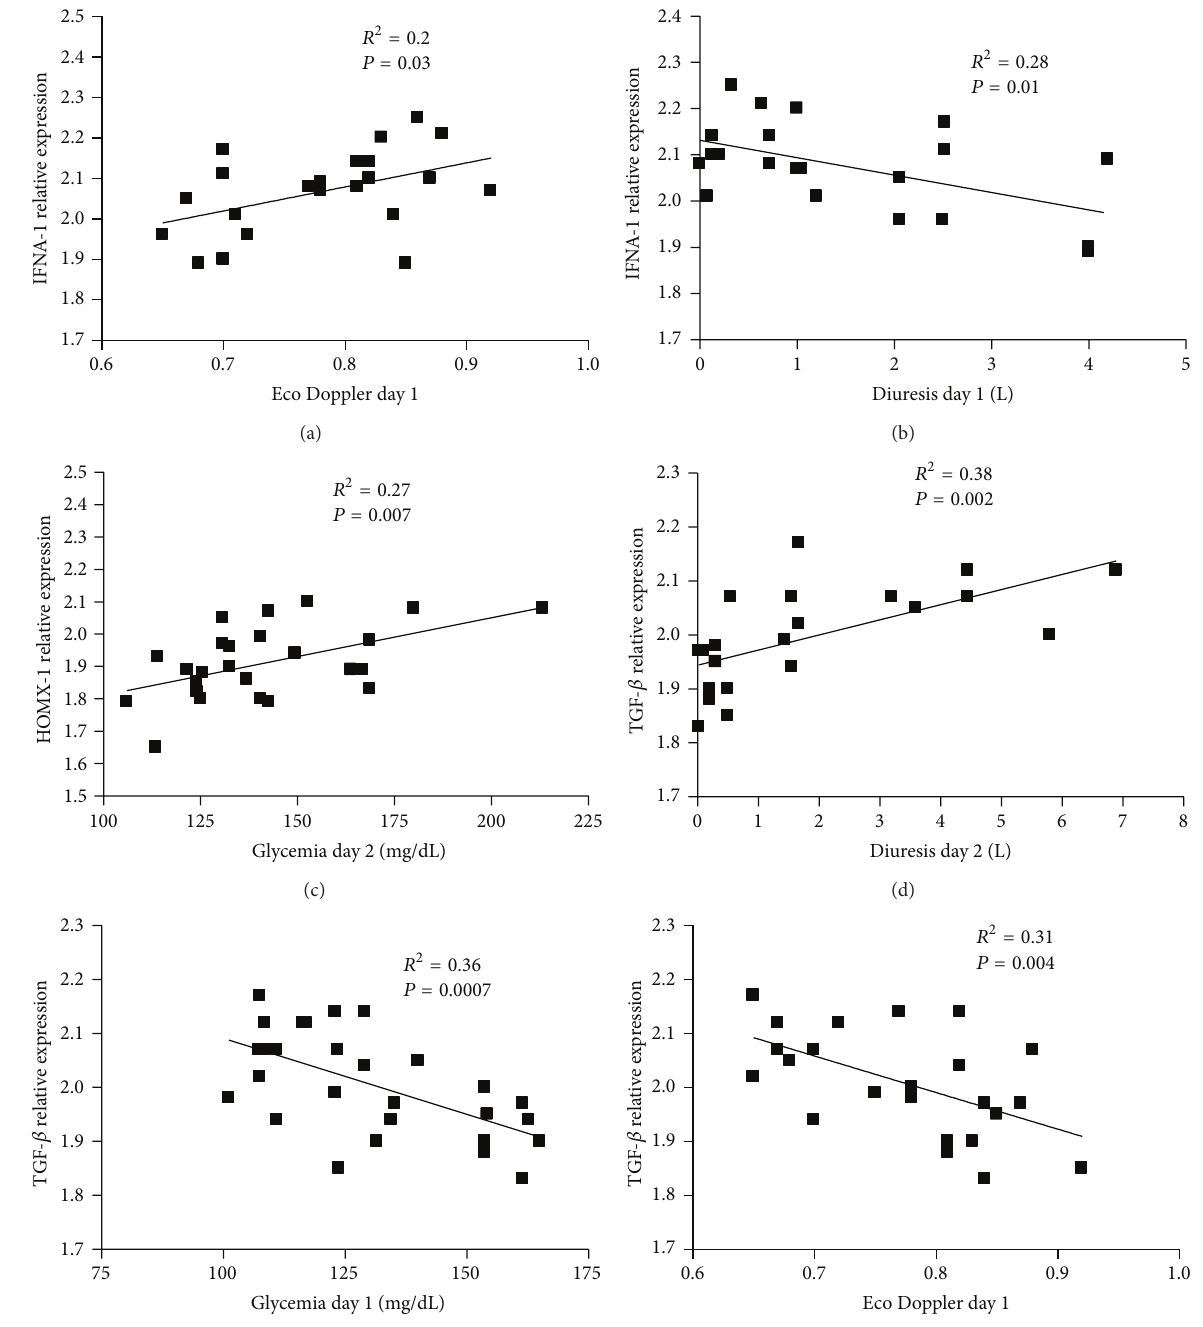
Figure 4: Correlation between the gene expression levels and kidney functional parameters. Correlation between Eco Doppler index of day 1 and IFNA1 (a), diuresis of day 1 and IFNA1 (b), glycemia of day 2 and HMOX-1 (c), diuresis of day 2 and TGF- 𝛽 (d), glycemia of day 1 and TGF- 𝛽 (e), and Eco Doppler index of day 1 and TGF- 𝛽 (f). Regression lines are shown in each figure with correlation coefficients ( 𝑅 2 ) and 𝑃